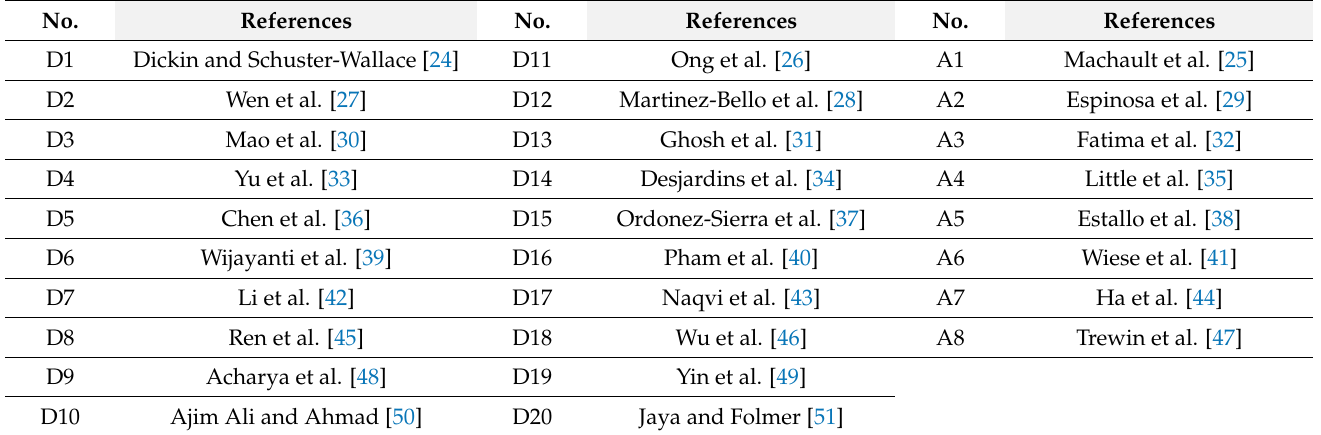
Table 2. List of publications selected for critical review.